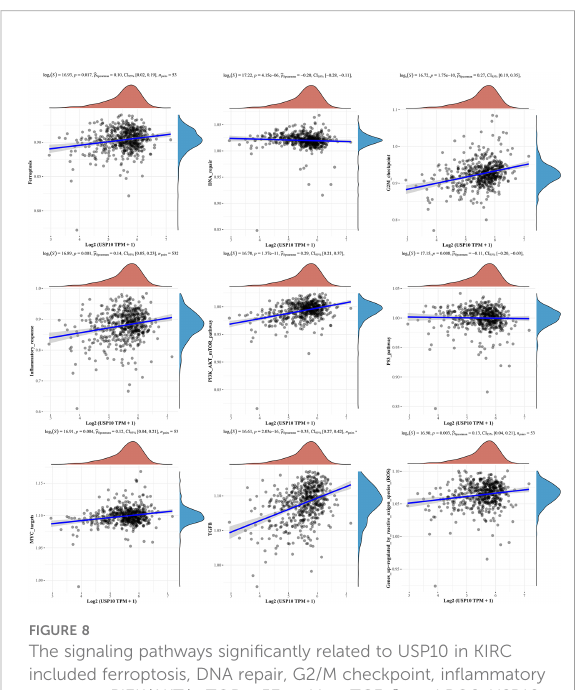
FIGURE 8 The signaling pathways signi fi cantly related to USP10 in KIRC included ferroptosis, DNA repair, G2/M checkpoint, in fl ammatory response, PI3K/AKT/mTOR, p53, c-Myc, TGF- b , and ROS.